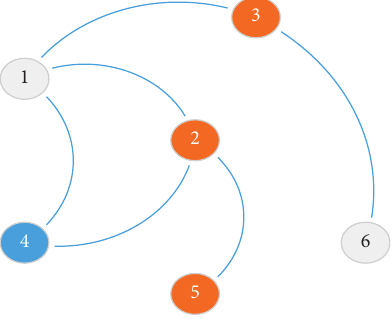
Figure 2: A simple network topology. Table 1: Probabilities of nodes being in each